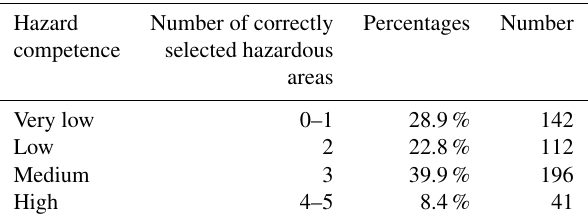
Table 4. Distribution hazard competence ( N =